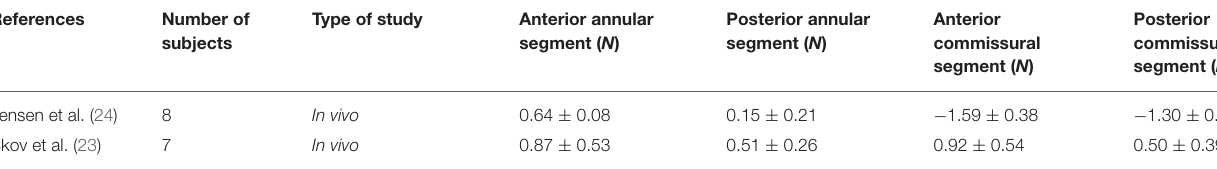
TABLE 3 | Overview of out-of-plane forces in the native mitral